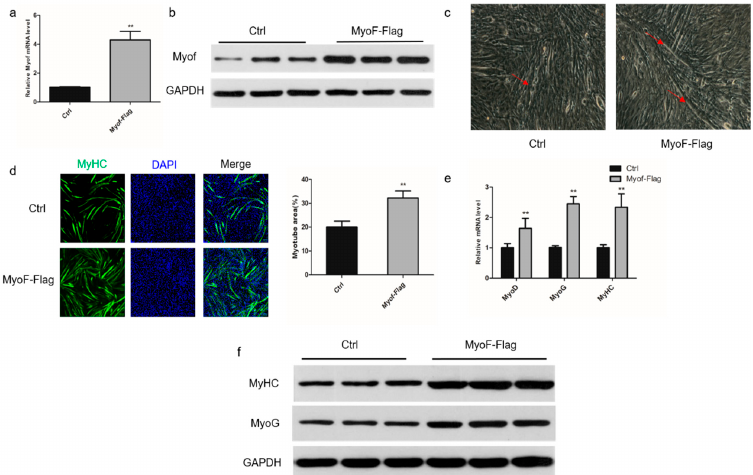
Figure 3. MyoF overexpression promotes myoblast differentiation. C2C12 myoblasts were transfected with the MyoF-Flag fusion protein plasmid or empty vector pcDNA3.1 (Ctrl), and were expanded in